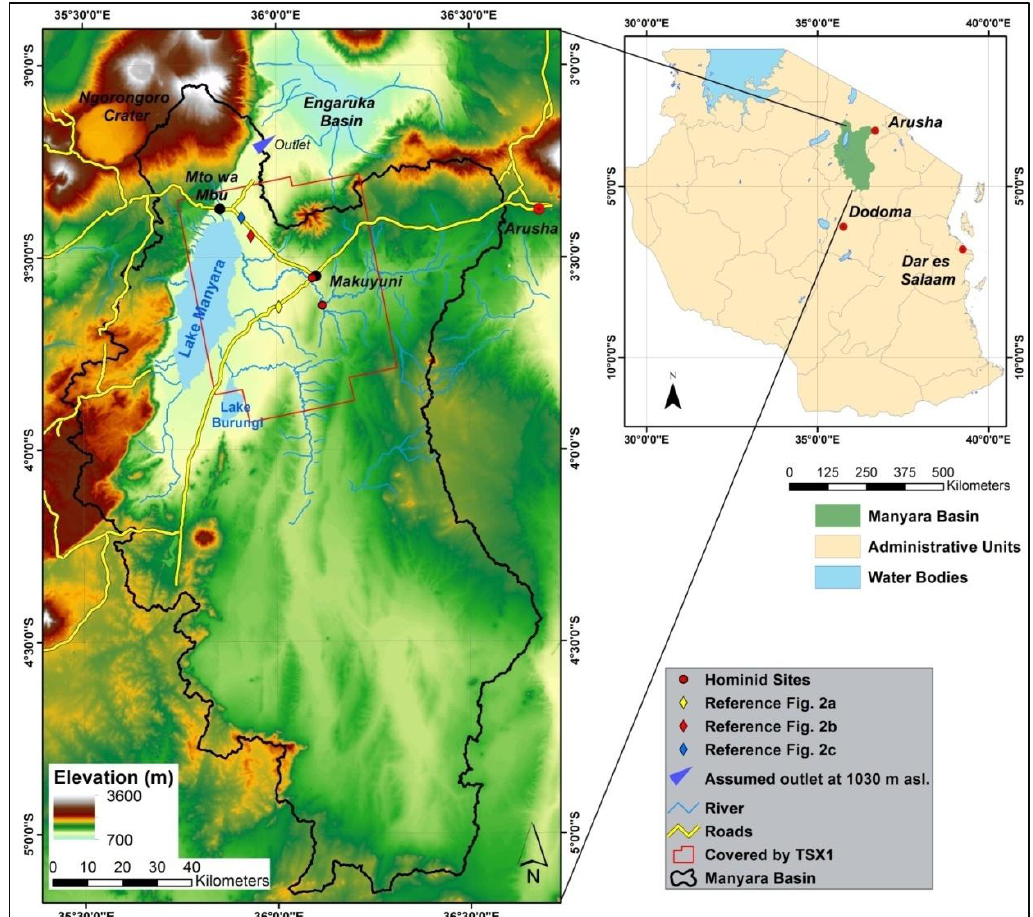
Figure 1. The Lake Manyara Basin in Northern